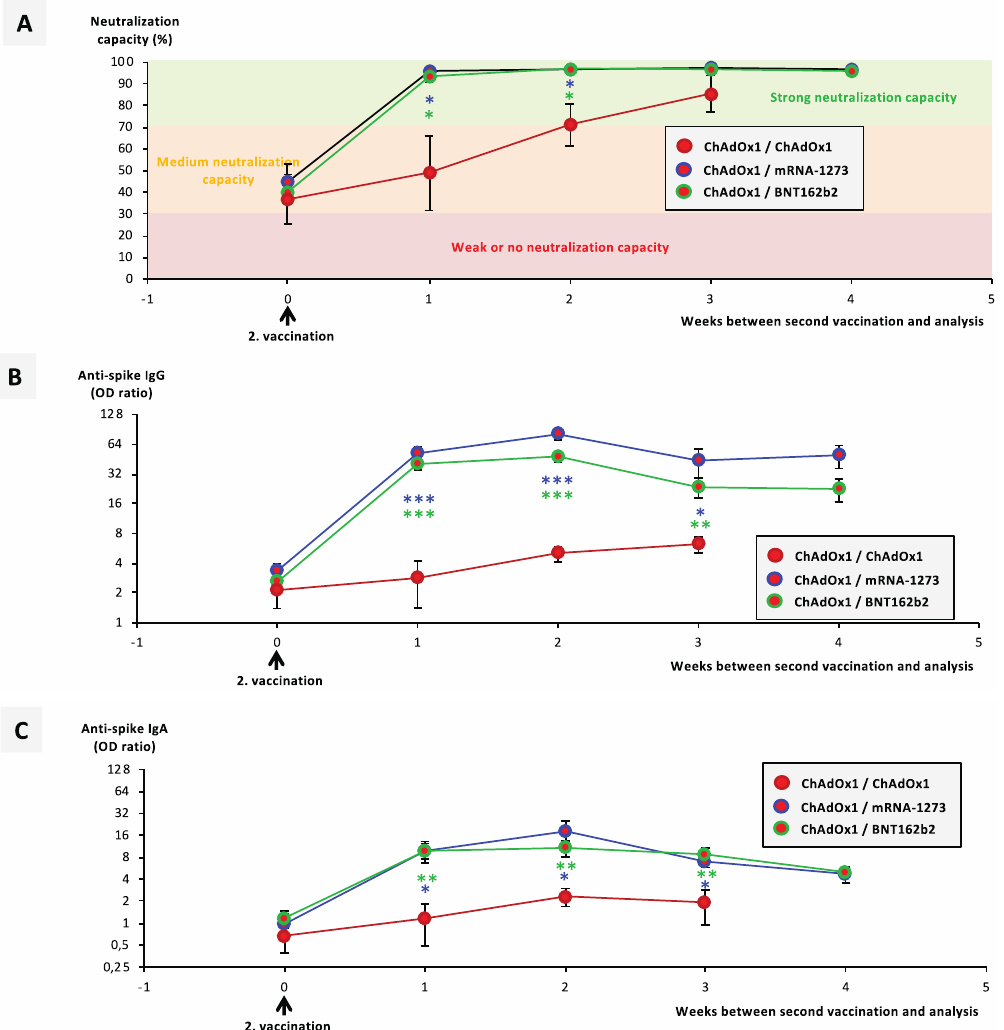
Figure 4. Impact of heterologous vaccination with ChAdOx1-nCoV-19 and an mRNA vaccine on neutralizing immune responses. Serum samples from 5 vaccinated individuals having received a homologous ChAdOx1-nCoV-19 vaccination (cohort H) and 36 vaccinated individuals having received a heterologous vaccination scheme (cohorts F and G) were collected at different timepoints after their second vaccinations. Line graphs show average courses for ( A ) the neutralization capacity of ACE2 – RBD interaction, ( B ) anti-spike IgG titers, and ( C ) anti-spike IgA titers from 26 ChAdOx1/BNT162b2, 10 ChAdOx1/mRNA-1273, and 5 ChAdOx1/ChAdOx1 vaccinated individuals at different timepoints after their second vaccinations, as indicated. Statistical analysis at each timepoint was performed using Dunn’s multiple comparisons test. Significance levels were * p < 0.05, ** p < 0.005, and *** p < 0.0005. Abbreviations: ACE2: angiotensin-converting enzyme 2; RBD: receptor-binding domain.